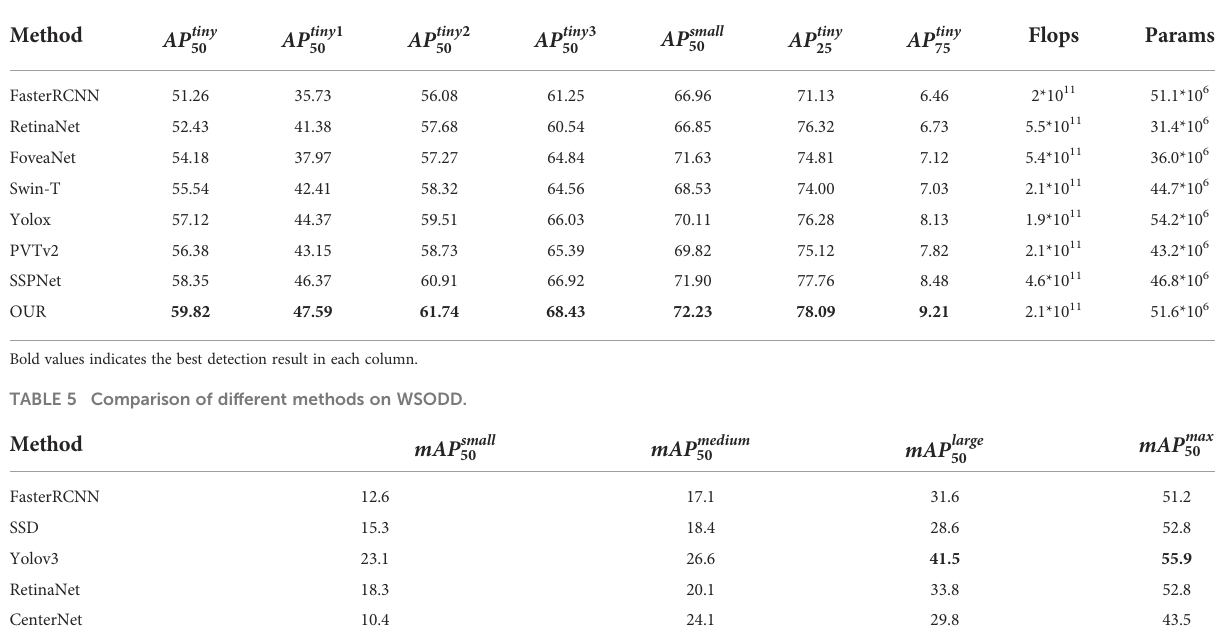
TABLE 4 Comparison of different methods on TinyPerson. Method